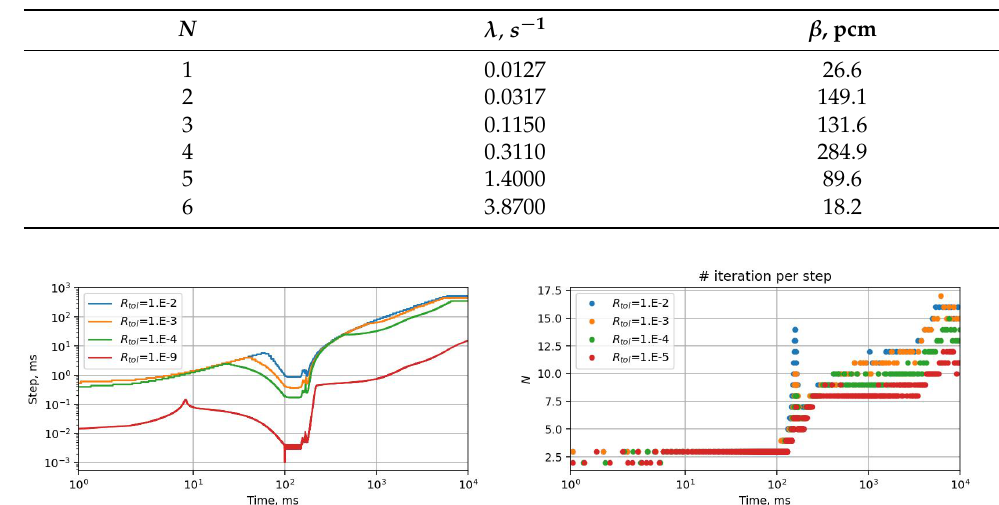
Table A4. Decay constant λ and fraction β of delay neutron precursors.